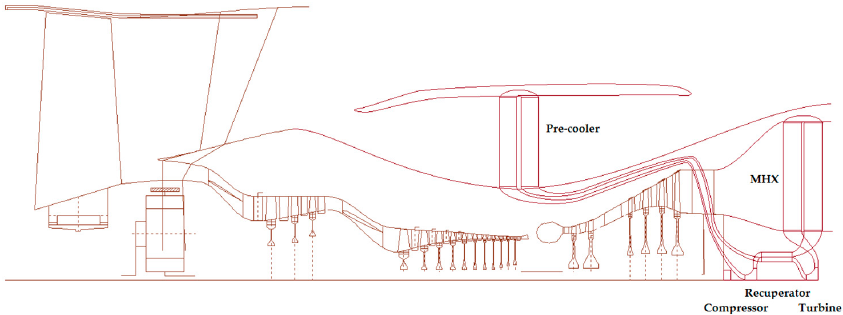
Figure 1. Rough schematic of a geared turbofan engine with a recuperated S-CO 2 bottoming cycle (RBC).